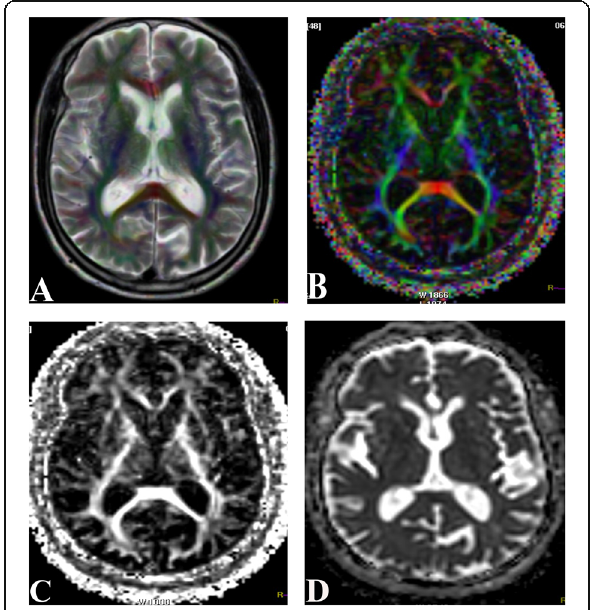
Fig. 1 Generation of FA and MD images: a FA T2 image, b FA colored directional map, c FA black and white map and d ADC map